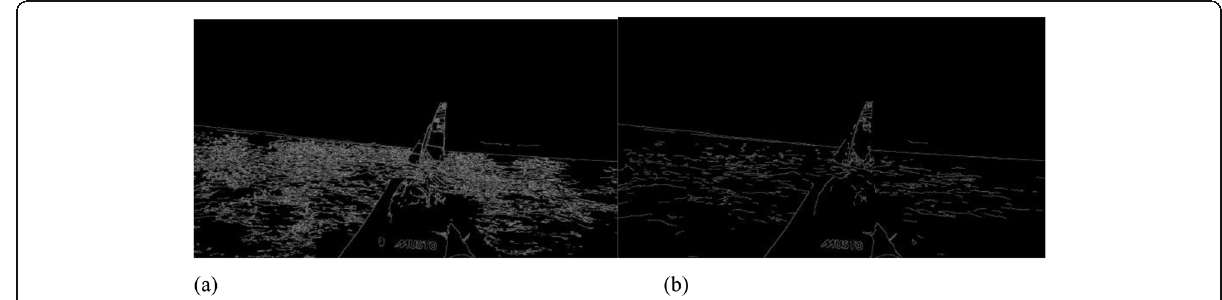
Fig. 2 Denoising a video frame using median blur. a : Result of Canny edge detection without denoising the frame; b : Result after denoising followed by the edge detection